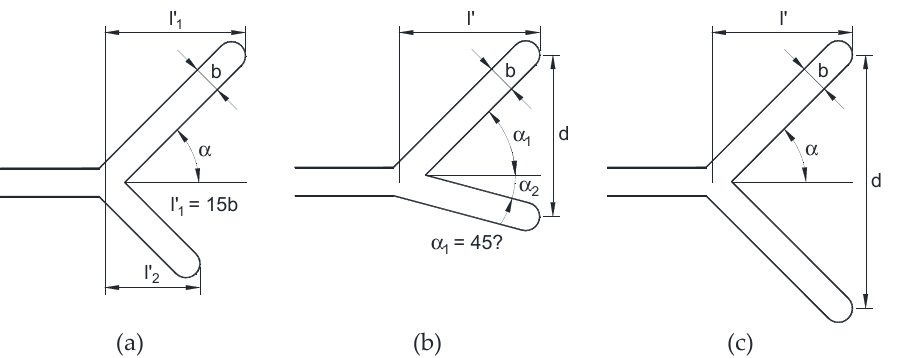
Figure 2. Initial geometry for the three bifurcated crack configurations: ( a ) different projected branch lengths; ( b ) different branch angles; ( c ) symmetric case.